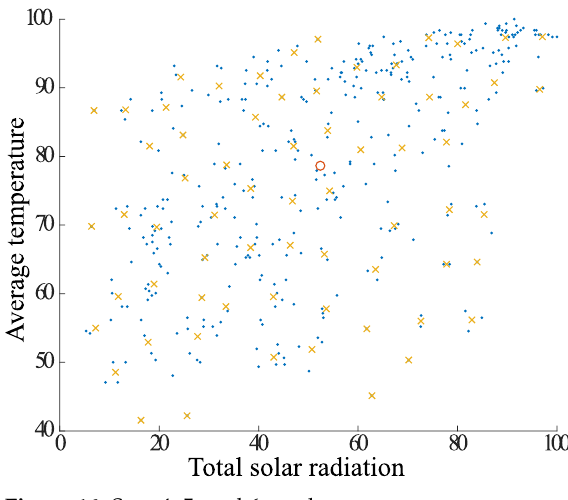
Figure 16. Step 4, 5, and 6 result.